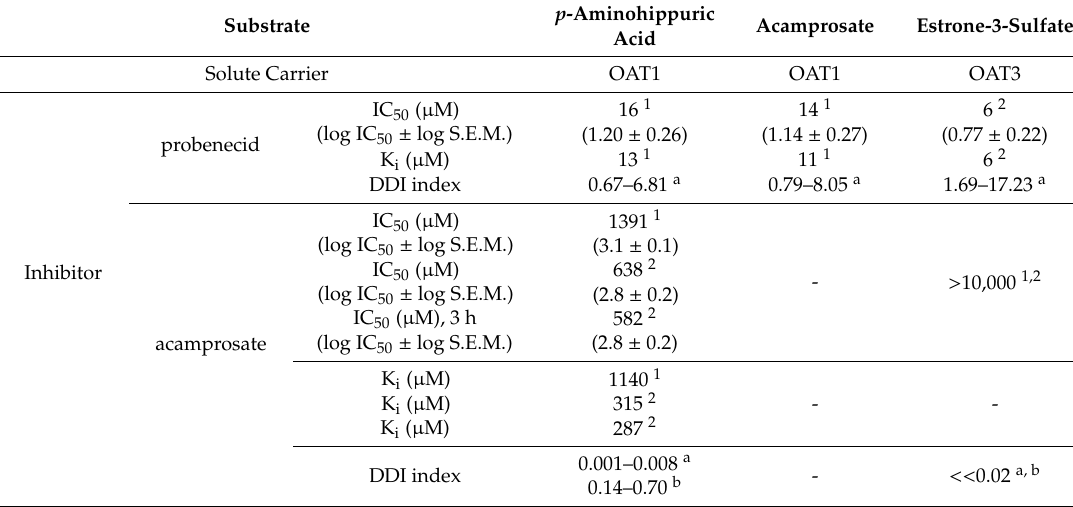
Table 2. Kinetic parameters associated with the inhibition of uptake of p -aminohippuric acid and acamprosateviaOAT1and estrone-3-sulfatevia OAT3 byacamprosateandprobenecidin HEK293-Flp-In cells. Data are reported as mean ± SEM of replicates in three cell passages in 1 Lab. 1 or 2 Lab.